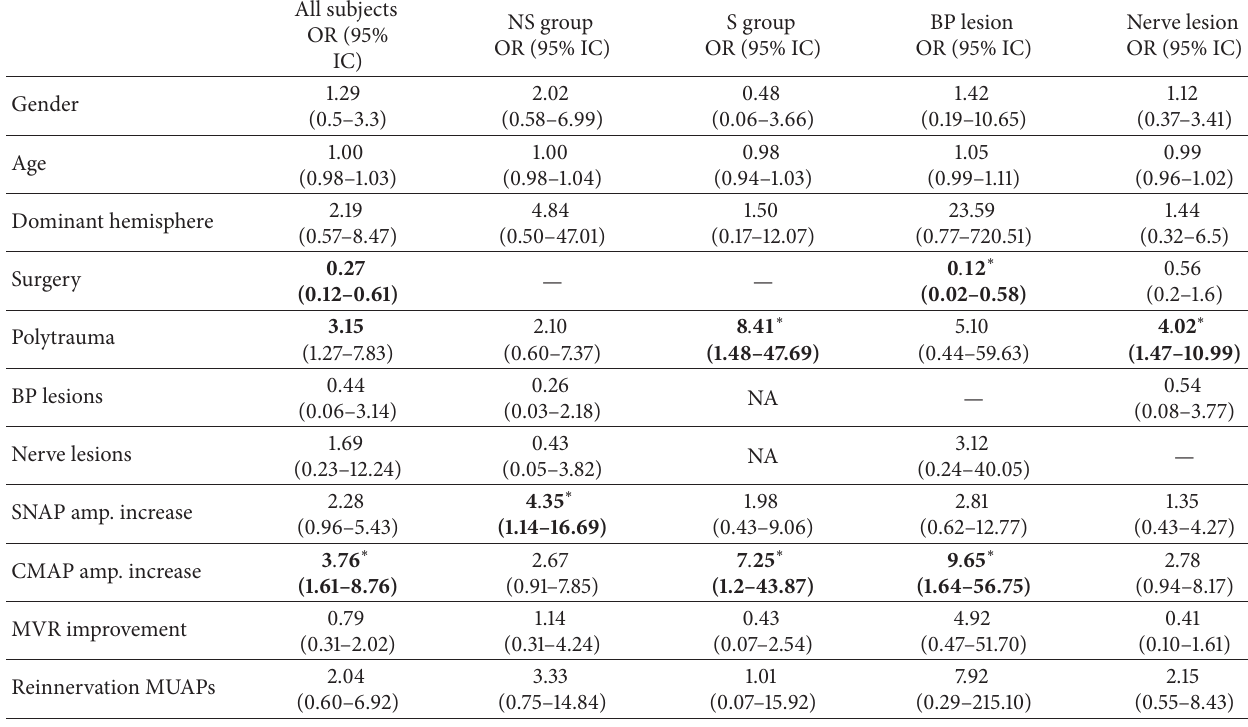
Table 3: Multiple regression analysis of clinical